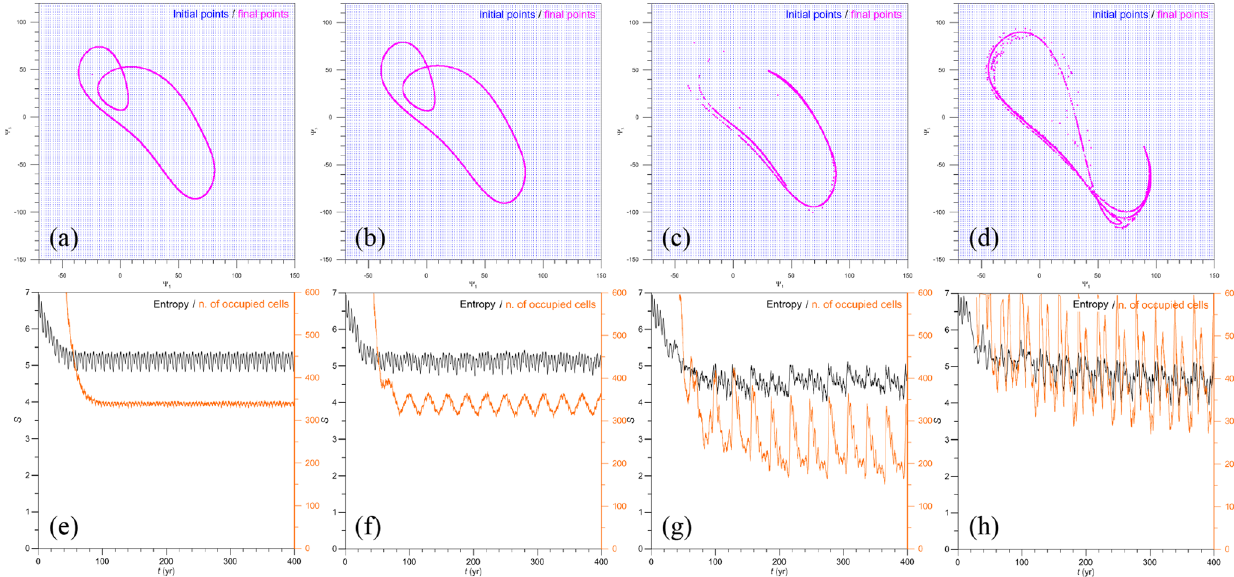
Figure 7. Intersection with the ((cid:57) 1 ,(cid:57) 3 ) plane at t = 400 years (magenta dots) of 15000 trajectories emanating from (cid:48) at t = 0 for γ = 1 . 1 and T p = 30 years. The complete set of the initial points covering (cid:48) is in blue. (a) (cid:15) = 0, (b) 0 . 05, (c) 0 . 10, and (d) 0 . 2. (e–g) The corresponding entropy S ϑ is plotted, along with the number n o of occupied 2